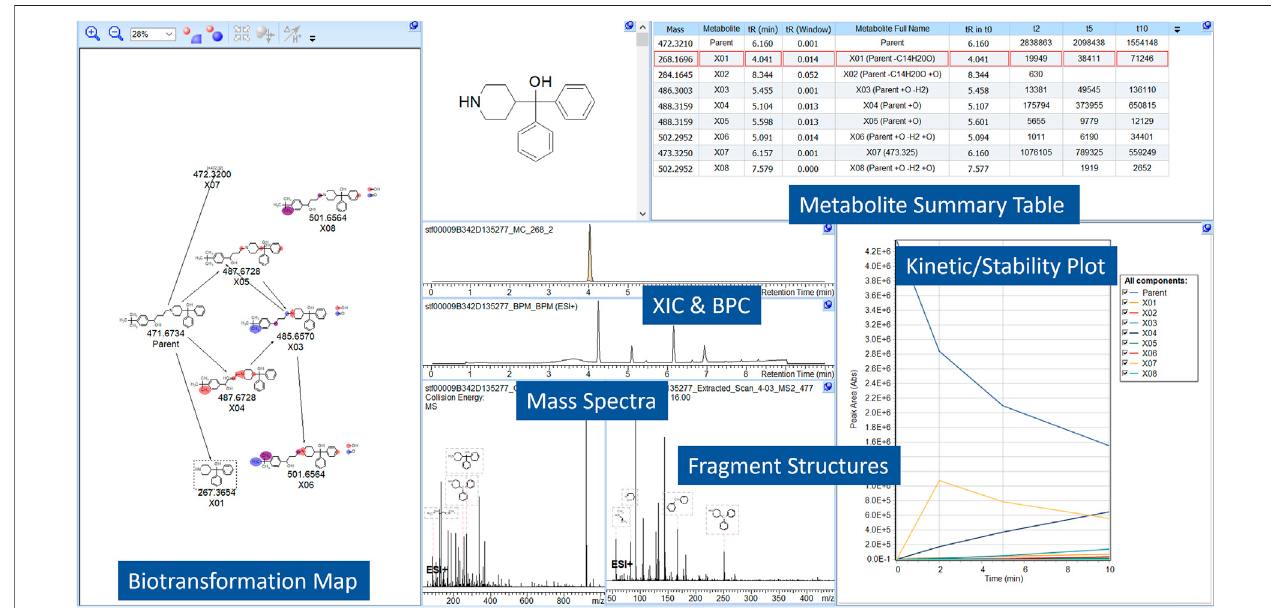
FIGURE 2 | A screen capture from MetaSense, showing the analysis of Terfenadine. The reactions present, absolute area, retention time and mass are notated in the Metabolite Summary Table (i.e., Parent +O) and resultant structures are visualized in the BTM. The Kinetic/Stability Plot allows users toassess formation/generation of metabolites across the entire